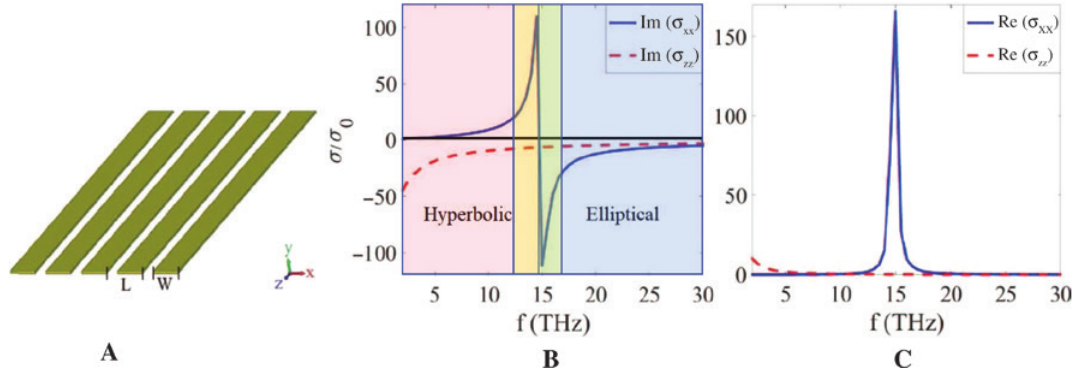
Figure 6: Graphene-based anisotropic and hyperbolic metasurfaces. (A) Array of graphene strips of width W and period L . (B) Imaginary parts of σ = e 2 /4 ħ ) for a graphene-strip array with τ = 0.35 ps, μ σ 0 (light blue) is anisotropic with elliptical dispersion. The yellow/green transition region is characterized by high losses in the x -direction. Adapted with permission from Ref.